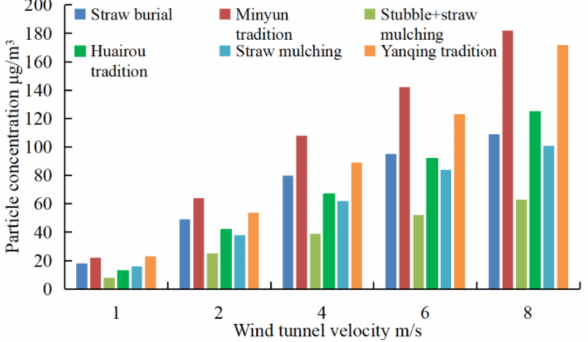
Figure 23. Changes of PM2.5 concentrations at 20 cm height under different wind